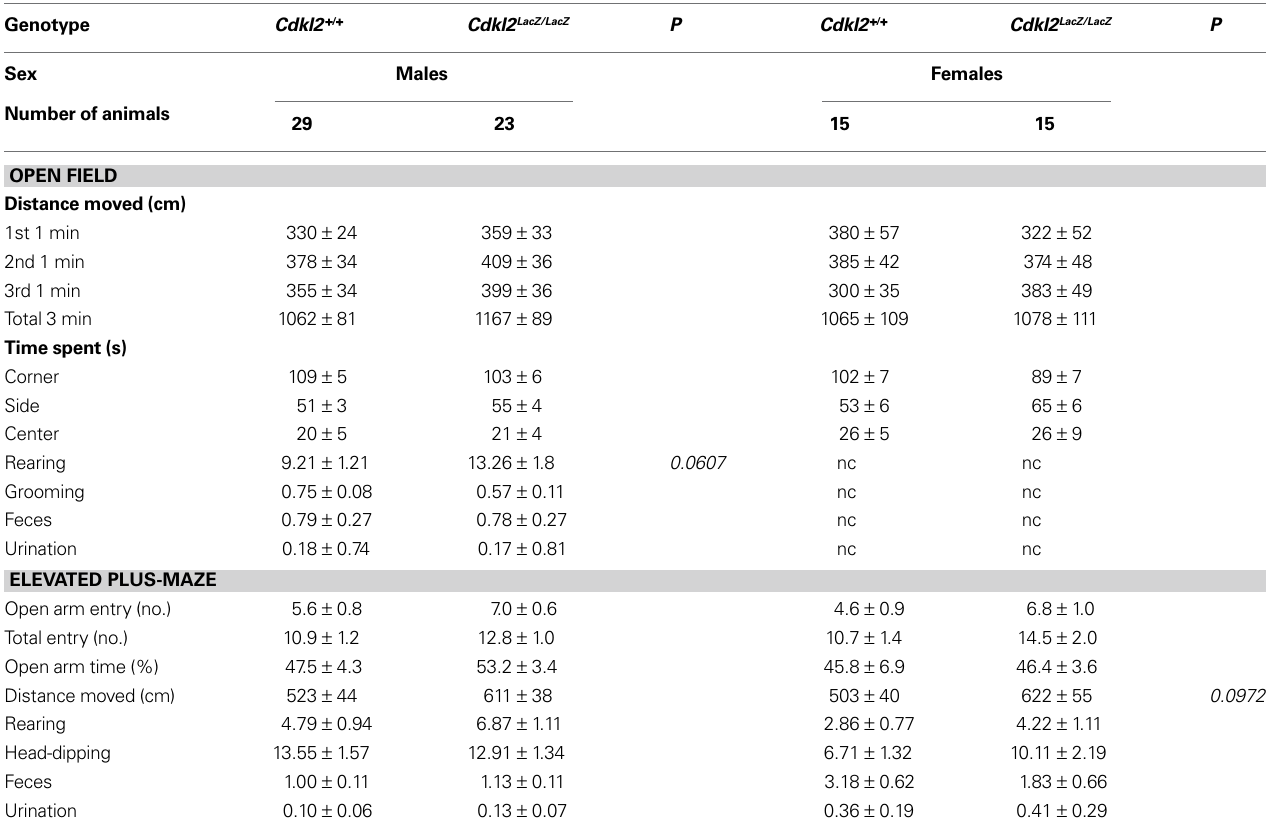
Table 1 | Measurement of animal behavior in open fi eld and elevated plus-maze.